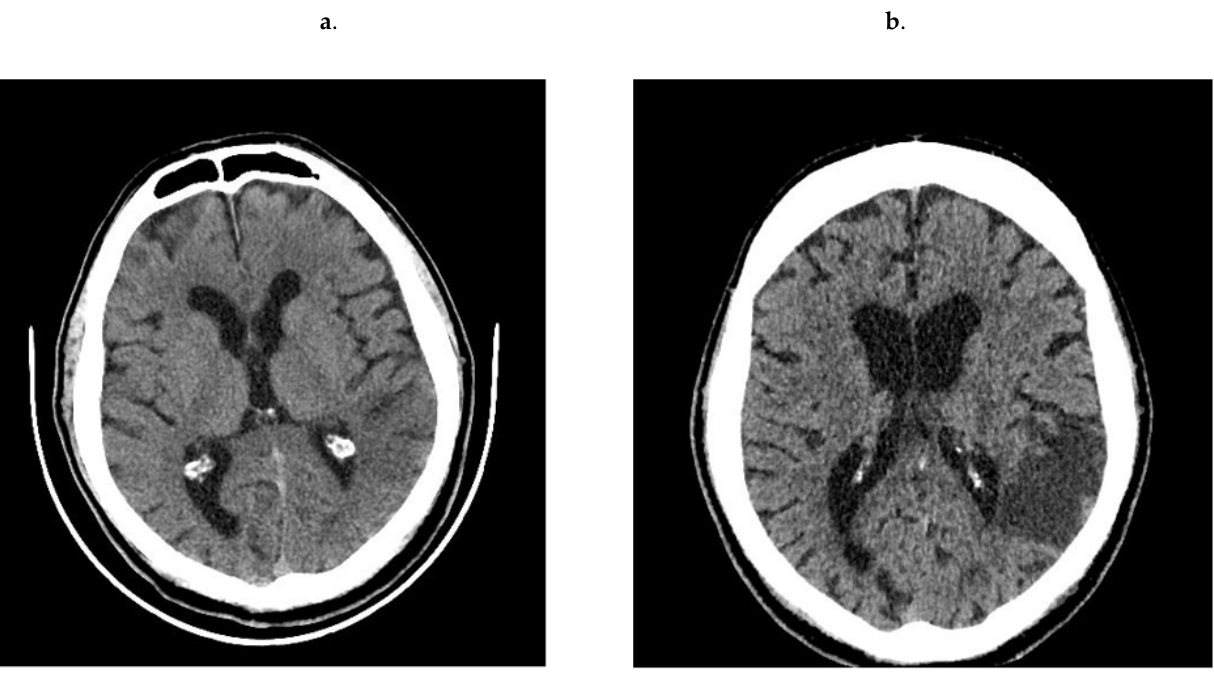
Figure 1. Ischemic lesion evolution between 1st day ( a ) and 7th day ( b ) in the no-contrast CT